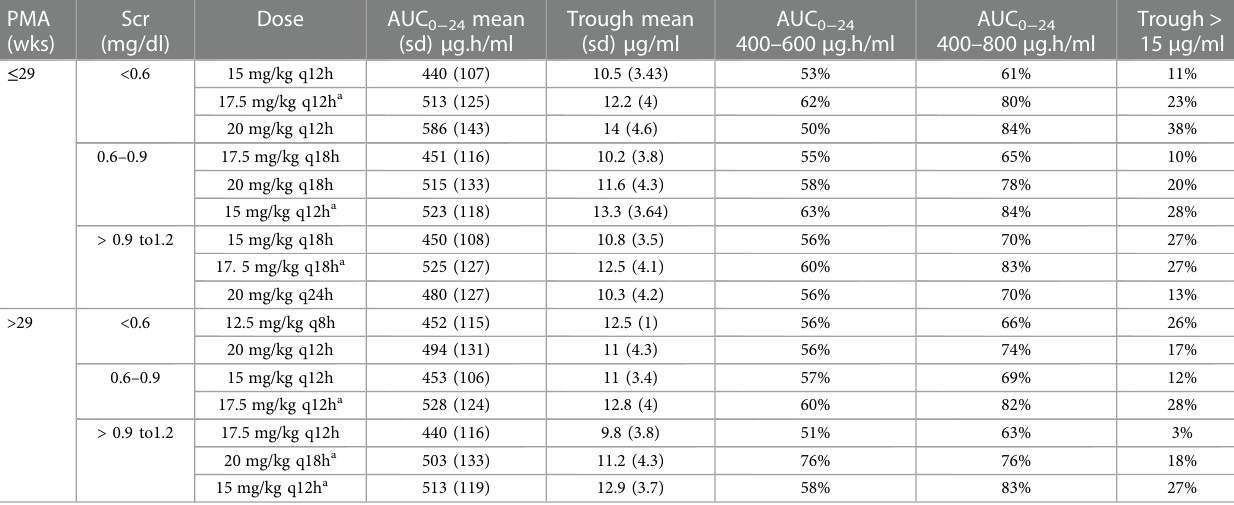
TABLE 4 Summary statistics of the predicted AUC and trough concentrations and Monte Carlo simulations for various dosing regimens of vancomycin in VLBW neonates. PMA